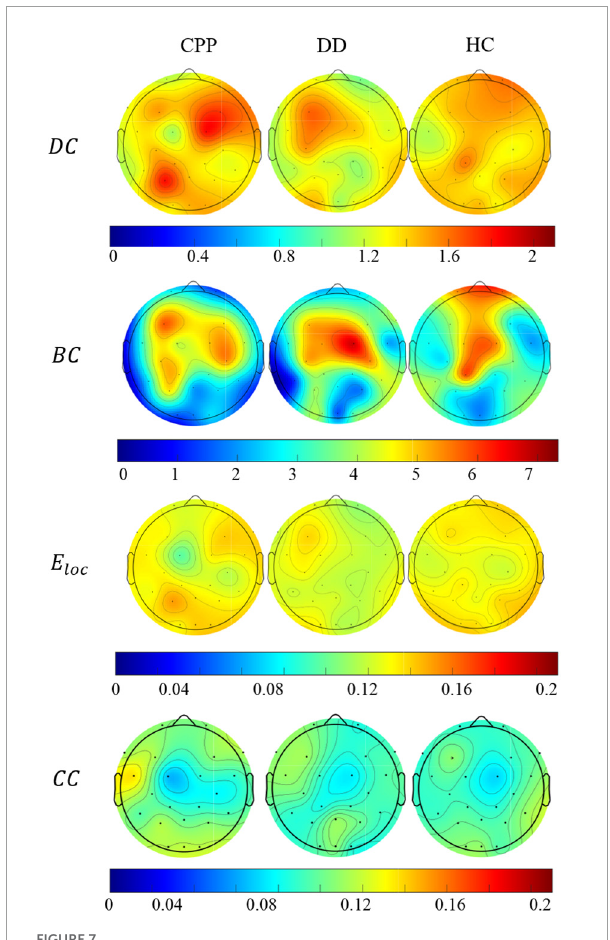
FIGURE7 The average distribution of degree centrality, median centrality, local efficiency, and clustering coefficient of the three groups of people in Theta band.